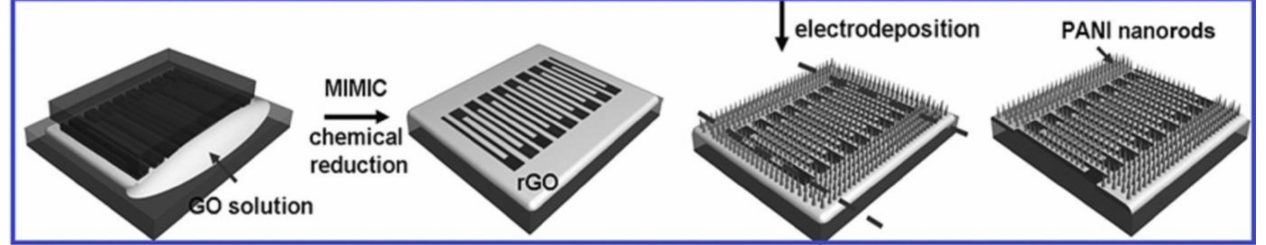
Figure 3. Fabrication of patterned interdigital finger PANI/rGO microelectrodes (Reprinted from [55] with permission of